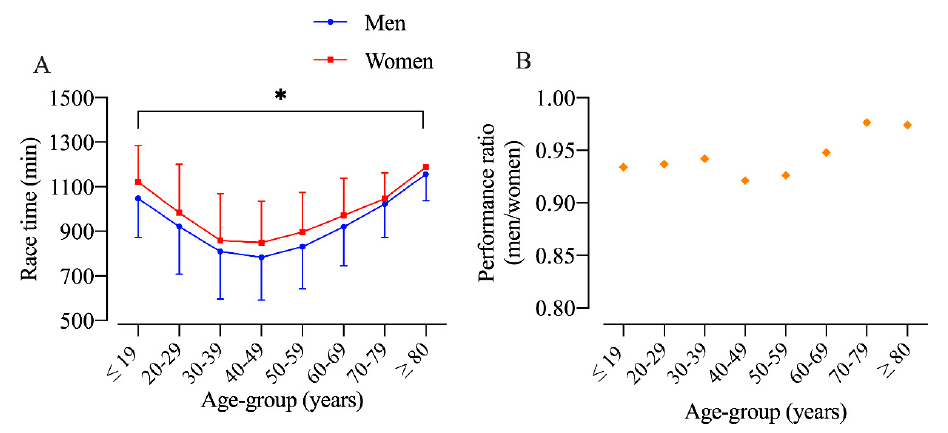
Figure 4. Performance of men and women in different age groups (A) and performance ratio (B) in the Biel ultramarathon. *: age-group effect ( p < 0.05).